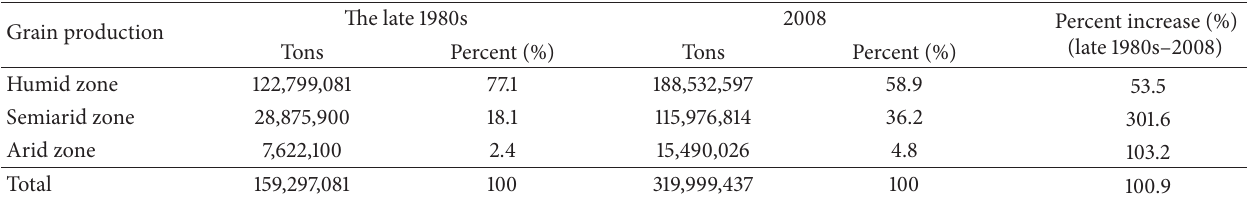
Table 4: Grain production in the late 1980s and 2008.